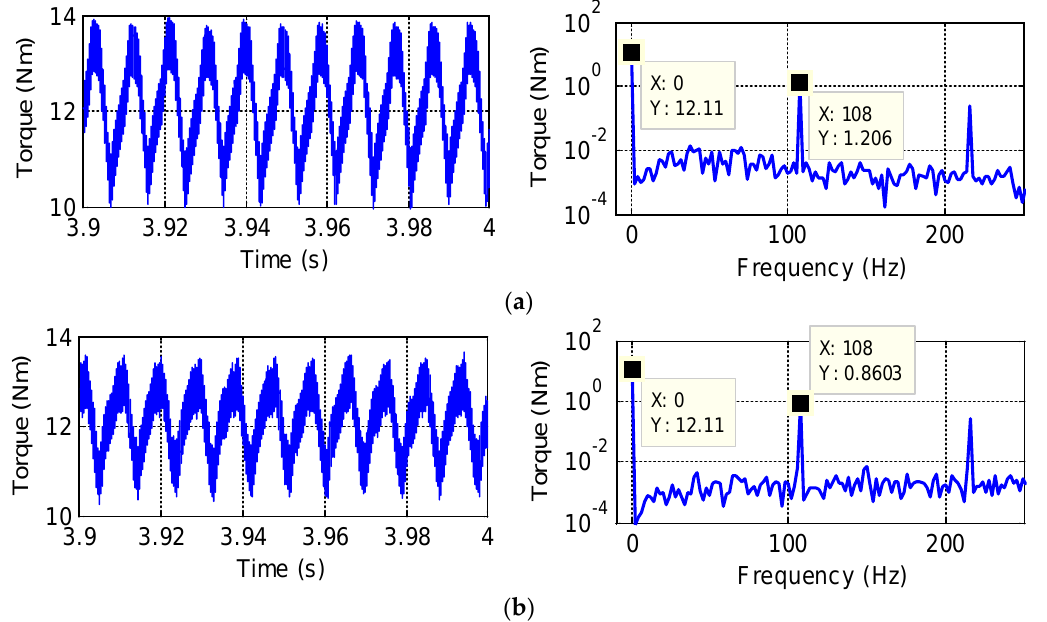
Figure 15. Waveforms and FFT results of torque at 270 r/min: ( a ) Before suppression; ( b ) After suppression.